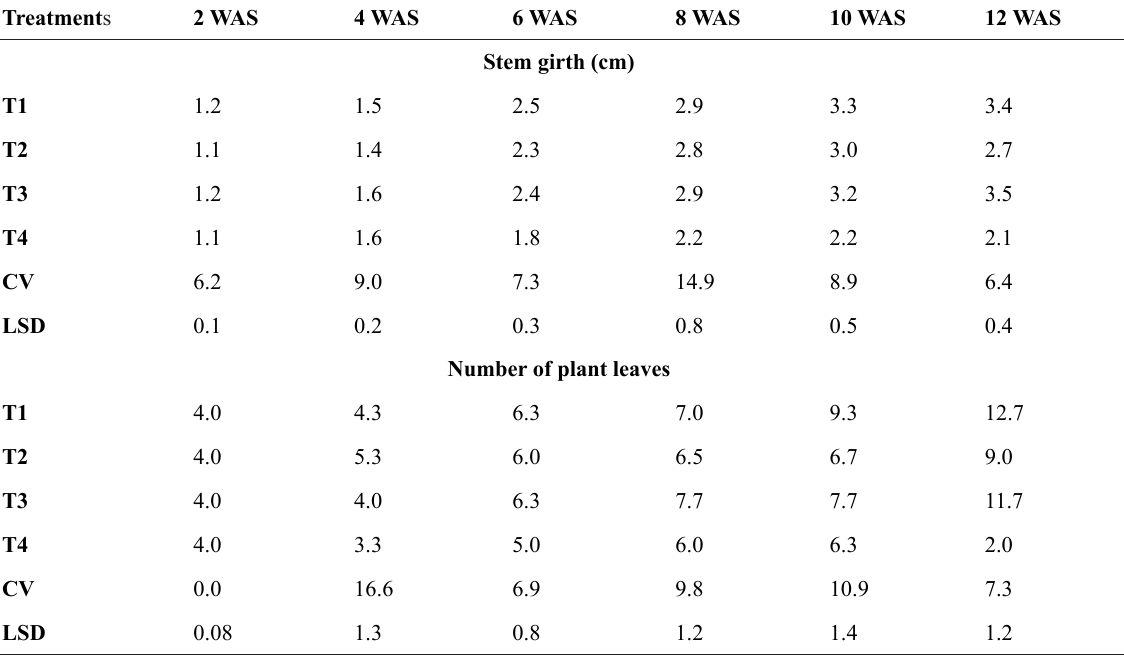
Table 4 Effect of manure application on okra stem girth and number of plant leaves Treatment